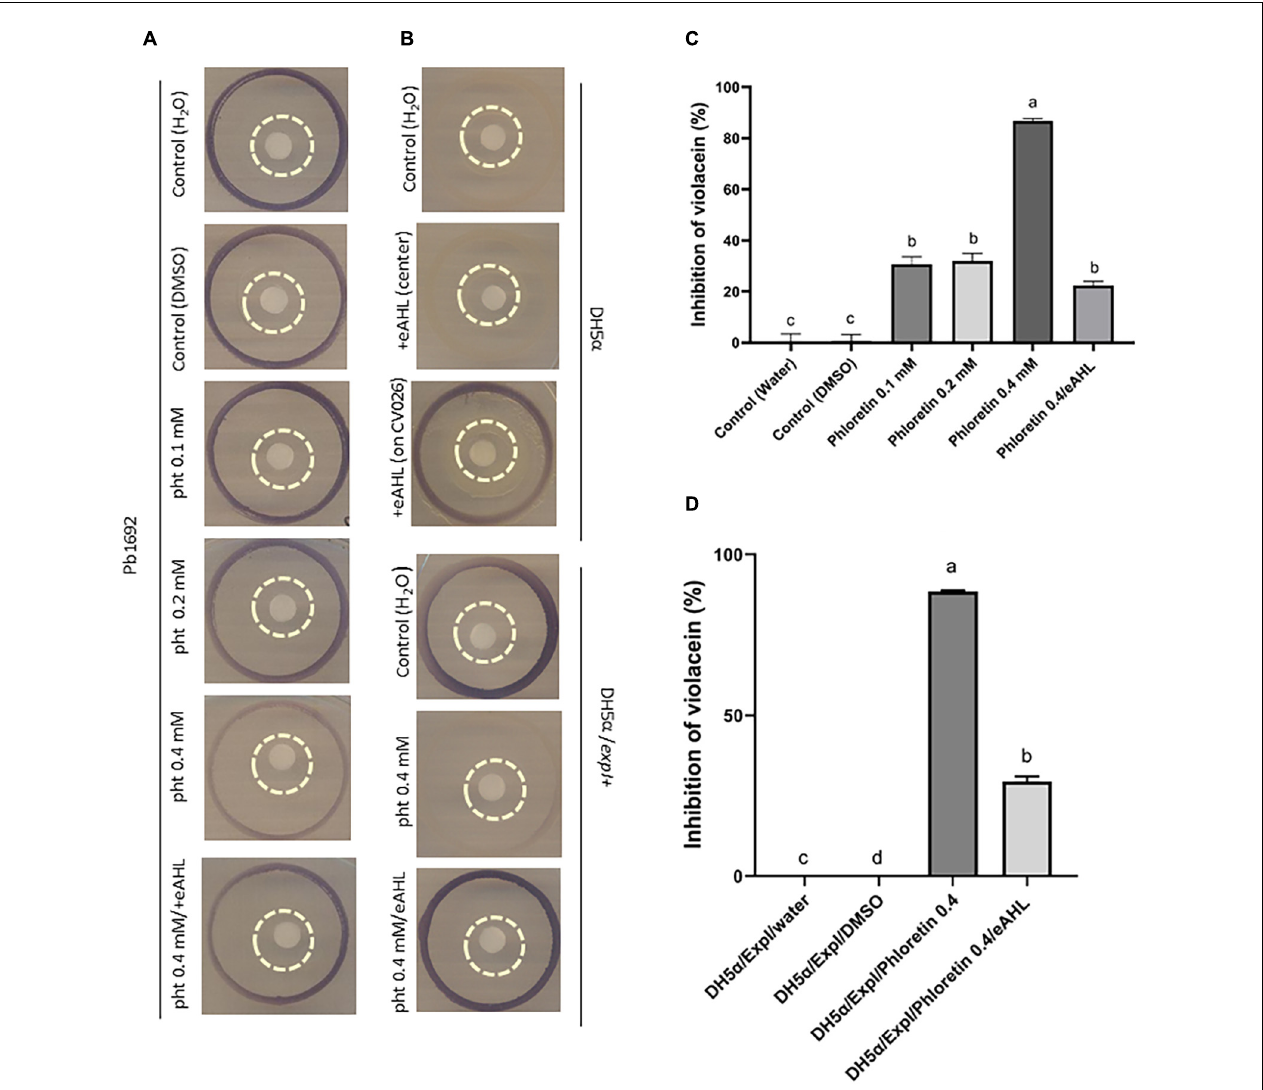
FIGURE 5 | Effects of phloretin on AHL synthesis by Pectobacterium brasiliense (Pb1692) (A,C) and by Escherichia coli DH5 α QS negative strain, complemented with expI from Pb1692 (B,D) . Visualization and evaluation of purple pigment (violacein) produced by CV026, in response to N -acyl-homoserine lactone (AHLs) produced by (A) Pb1692 and (B) transformed DH5 α (pGEM), or DH5 α complemented with expI ( DH5 α /pGEM expI ). The bacteria were treated with 30 µ L of dH 2 O or 0.3% (vol./vol.) of DMSO (control) or with phloretin. External AHL, eAHL, 30 µ l of 500 nM of [ N –(3–oxohexanoyl)–L–homoserine lactone (3-oxo-C 6 - HSL) was applied to the central paper disc with phloretin 0.4 mM. The outer circle contained CV026, Pb1692 or DH5 α /pGEM expI were at the inner circle, and treatments were applied on the central paper disc. [ (B) upper section] QS-negative DH5 α (pGEM), treated with 30 µ L of dH 2 O or eAHL (500 nM) at the center of the paper disc. Positive control, 30 µ L of eAHL (500 nM) added directly on the outer circle, to get the purple pigment. [ (B) lower section] DH5 α strain expressing AHL synthase of Pb1692 (pGEM expI ) treated with 30 µ l of dH 2 O or phloretin (0.4 mM). External AHL, N -( β -Ketocaproyl)-L-homoserine lactone (eAHL), 30 µ l of 500 nM of AHL was applied to the central paper disc with 0.4 mM phloretin. (C) Quantitative determination of QS inhibition, shown as percent (%) of violacein inhibition by phloretin (0.1, 0.2, 0.4 mM, and 0.4 mM/eAHL), relative to dH 2 O or DMSO controls. (D) Quorum-sensing inhibition expressed as percent (%) violacein inhibition by phloretin (0.4 mM or 0.4 mM/eAHL) relative to the dH 2 O and DMSO controls. Data represent means ± SE of 4 replicates in 3 independent experiments. Bars that are not labeled with the same letter are significantly different from each other ( P <